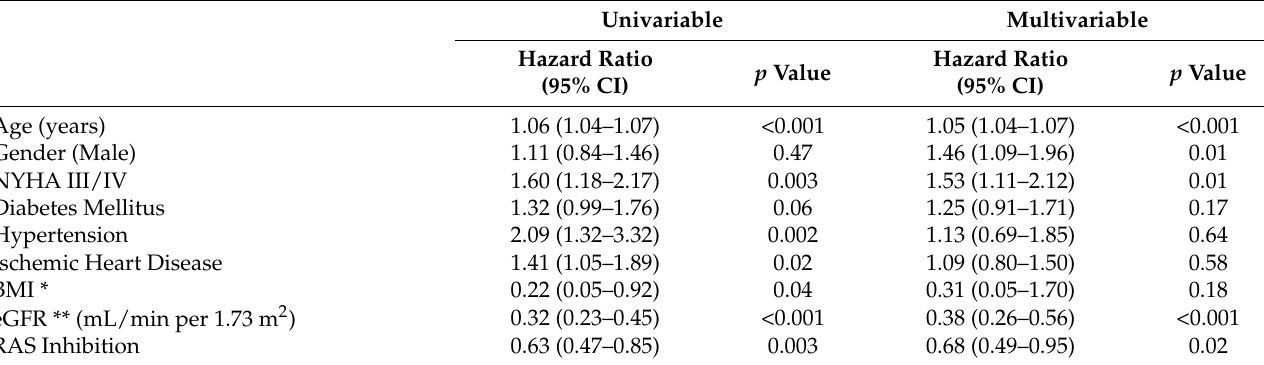
Table 2. Predictors of mortality by Cox regression